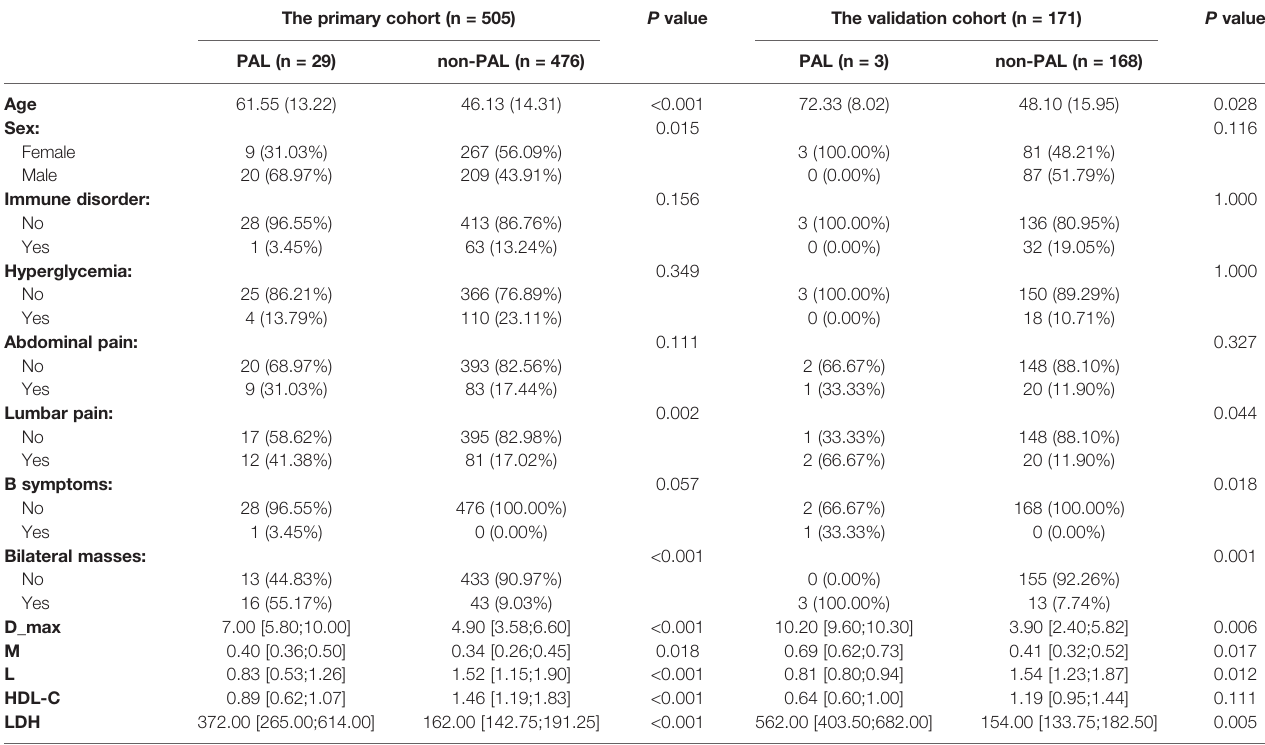
TABLE 2 | The basic characteristics of the primary and validation cohort patients.